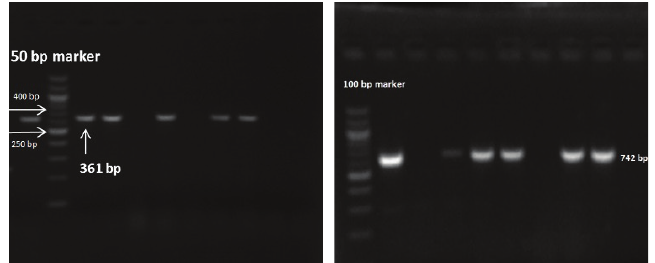
Figure 1 - SDSE (361bp) and S. anginosus (742 bp) isolates gel electrophoresis of groESL -PCR products.